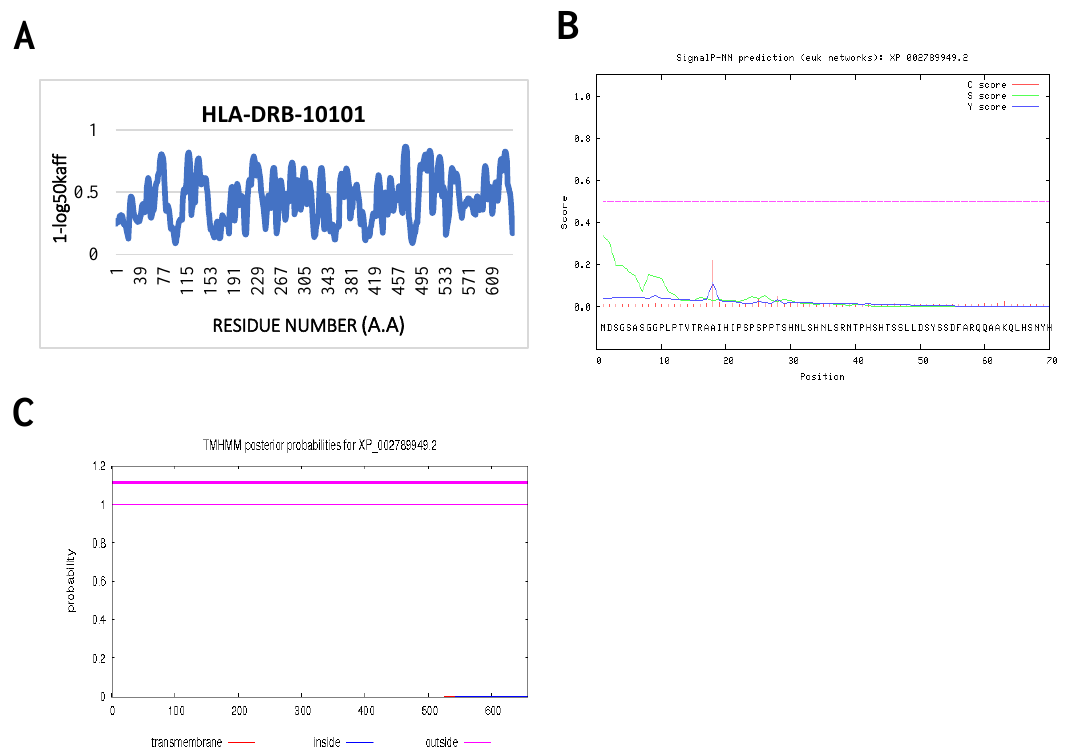
Figure 4. Analysis of the interaction of the phosphoenolpyruvate carboxy kinase protein (PAAG_08203) by integrating di ff erent algorithms. ( A ) Signal peptide prediction (signal peptide). ( B ). Prediction of transmembrane regions (TMHMM). ( C ). Prediction of MHC II epitopes (NetMHCII).